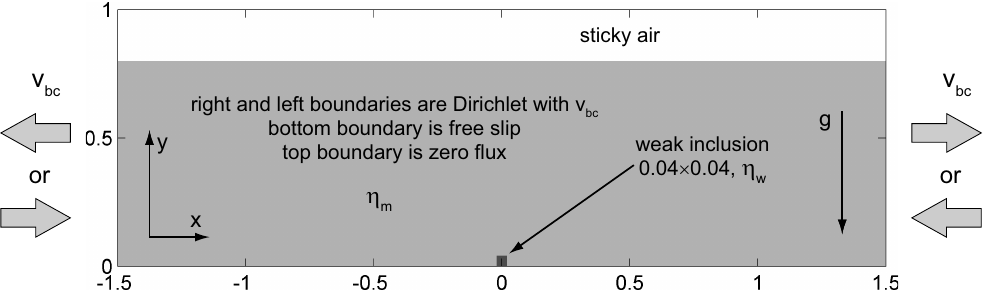
Figure 18. Extension/compression model setup. Table 3. Model parameters for brittle extension/compression